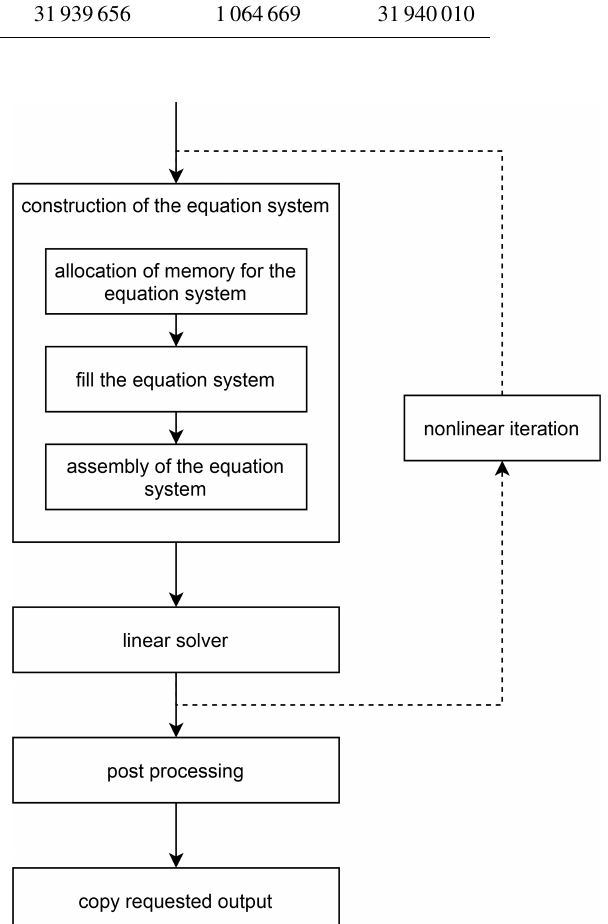
Figure 1. The sequence of modules in a transient time step in ISSM. Small grey circles indicate the dimension of the equations of the module (3-D, 2-D). Larger grey circles with PDEs are denoting if and how many partial differential equations are solved. Diamonds with “par” indicate that only an algebraic equation is evaluated. On the right side, we list the DOF for particular mesh resolutions and modules.